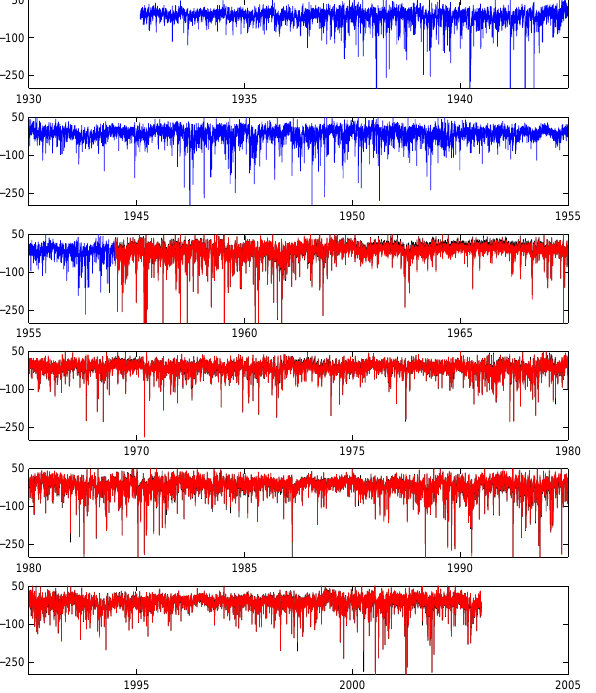
Fig. 2. The reconstructed D st in 1932–1956 (blue) and in 1957– 2002 (red). The original D st in 1957–2002 (black) is depicted under the reconstructed D st .